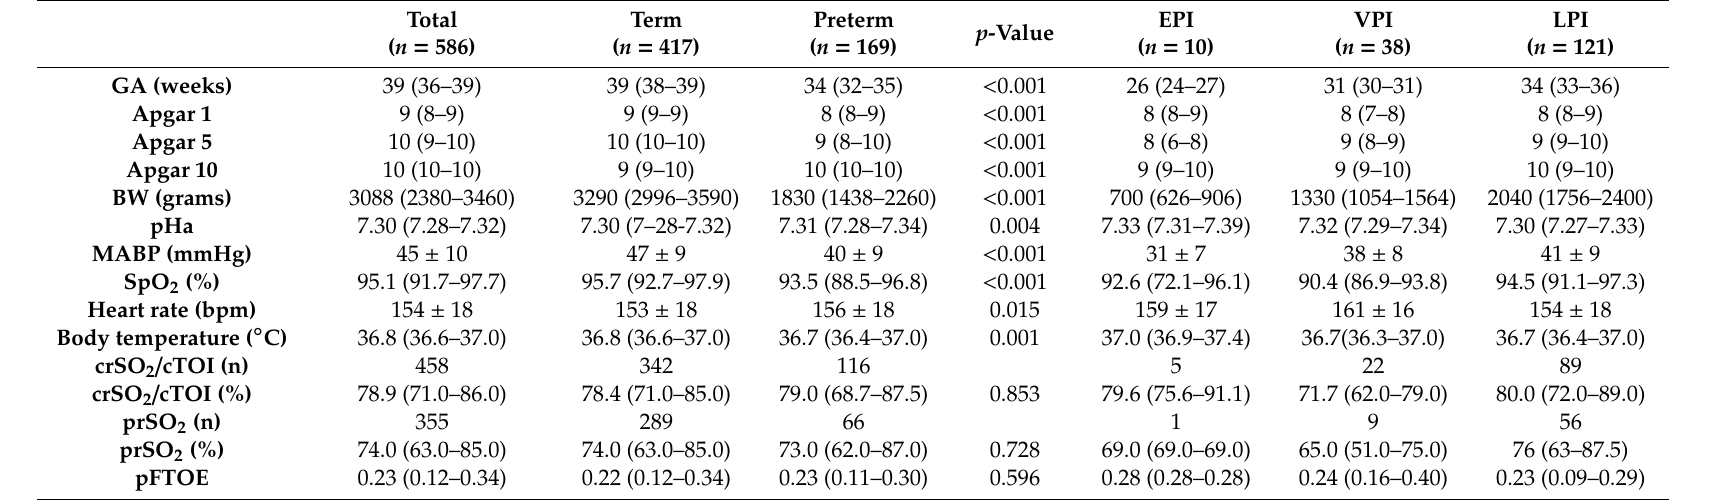
Table 1. Demographic data of the whole cohort, preterm and term born neonates, as well as of the subgroups EPI (extremely preterm infants ≤ 28 + 0 weeks of gestation), VPI (very preterm infants > 28 + 0 and < 32 + 0 weeks of gestation), and LPI (late preterm infants ≥ 32 + 0 and < 37 + 0 weeks of gestation). Data are expressed as mean ± standard deviation or median (interquartile range). Gestational age (GA), birth weight (BW), umbilical arterial pH (pHa), mean arterial blood pressure